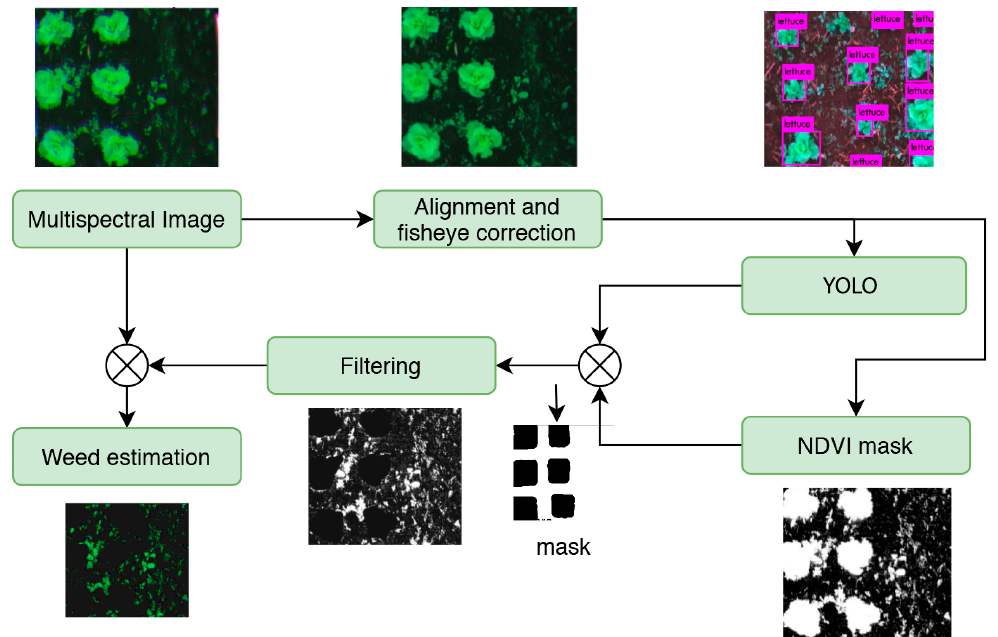
Figure 5. A diagram of method 2 based on convolutional neural network YOLOv3: it shows the sequence for preparation, crop detection, weed identification using an NDVI (normalized difference vegetation index) mask, and weed coverage